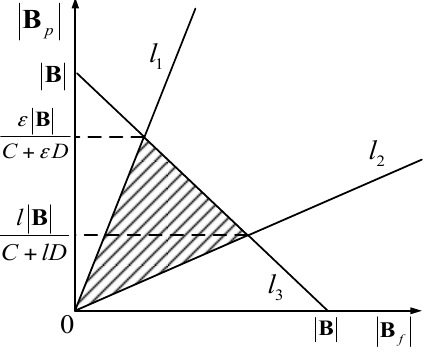
Figure 2. Available area for Equations (22)–(25).